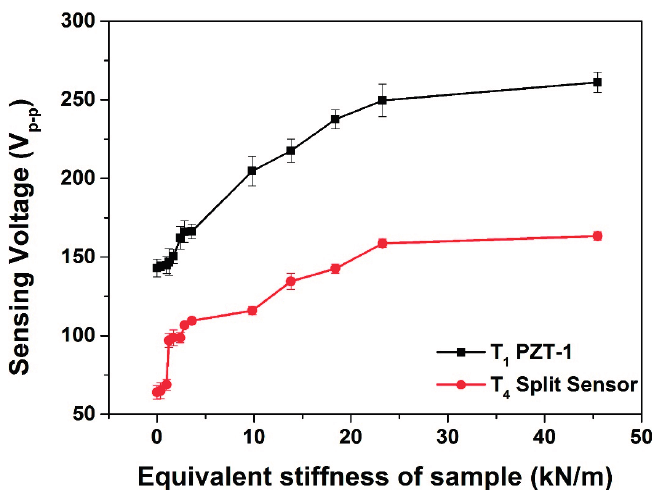
Figure 10. Sensor voltages at various equivalent